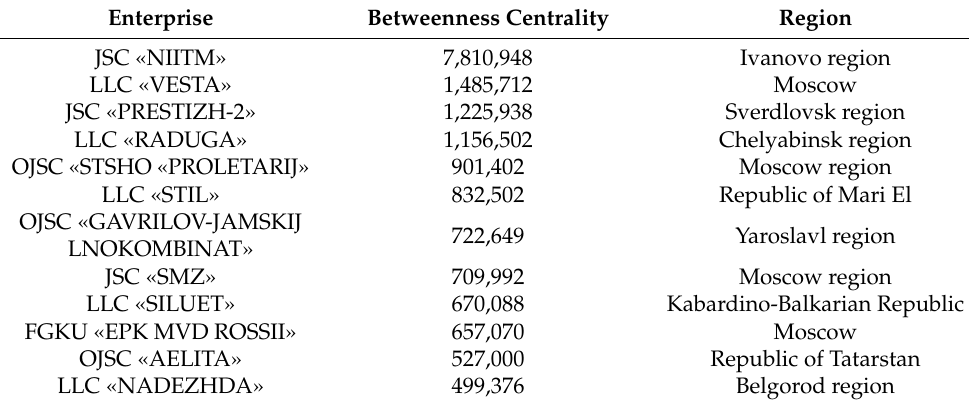
Table A1. Textile enterprises with the highest «betweenness centrality» metrics.